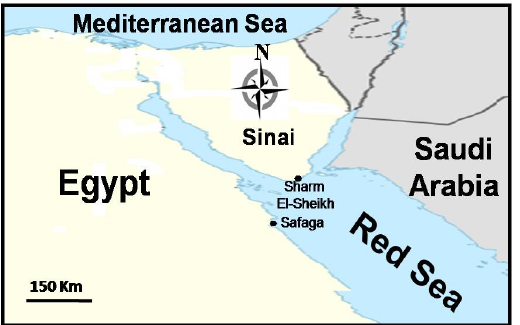
Figure 1. A map showing the location of Sharm El ‐ Sheikh, South Sinai, Egypt, and Safaga (133 km south of Sharm El ‐ Sheikh).